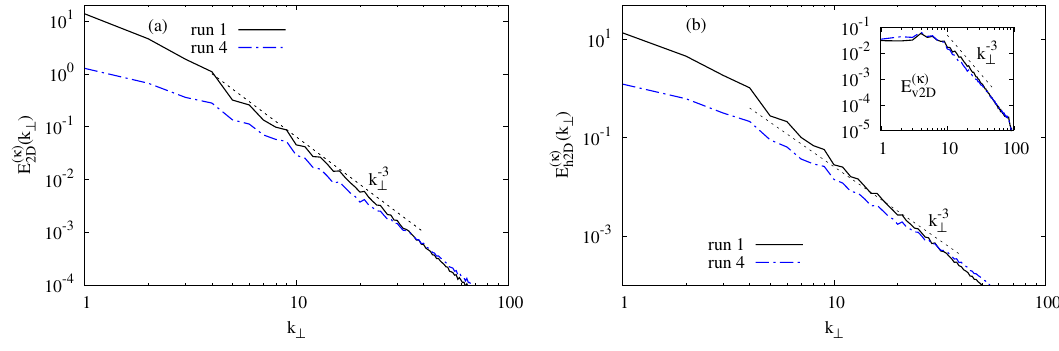
( κ ) ( k ⊥ ) associated 2 D